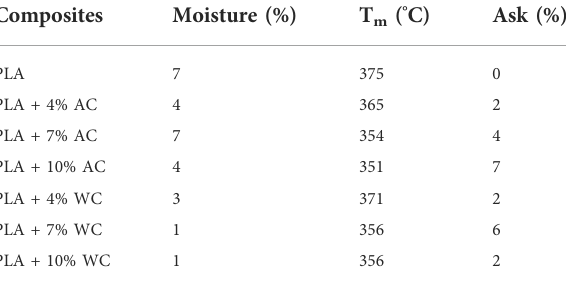
TABLE 2 Thermogravimetric data of PLA and reinforced composites by AC and WC at different